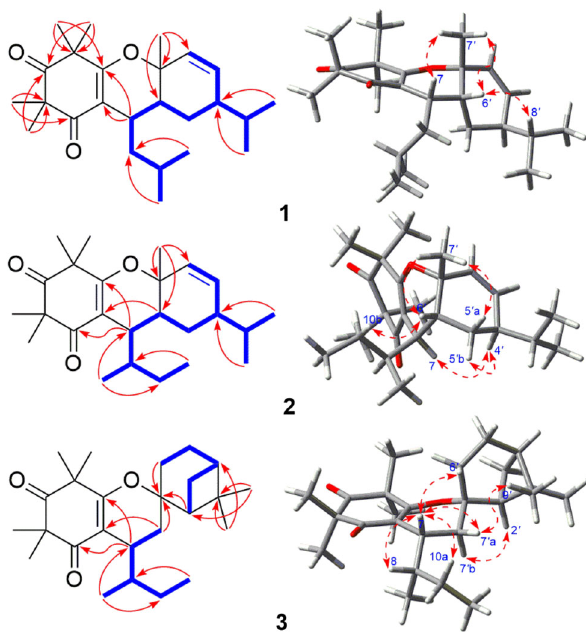
Fig. 2 Key 1 H– 1 H COSY, HMBC, and ROESY correlations of 1 –